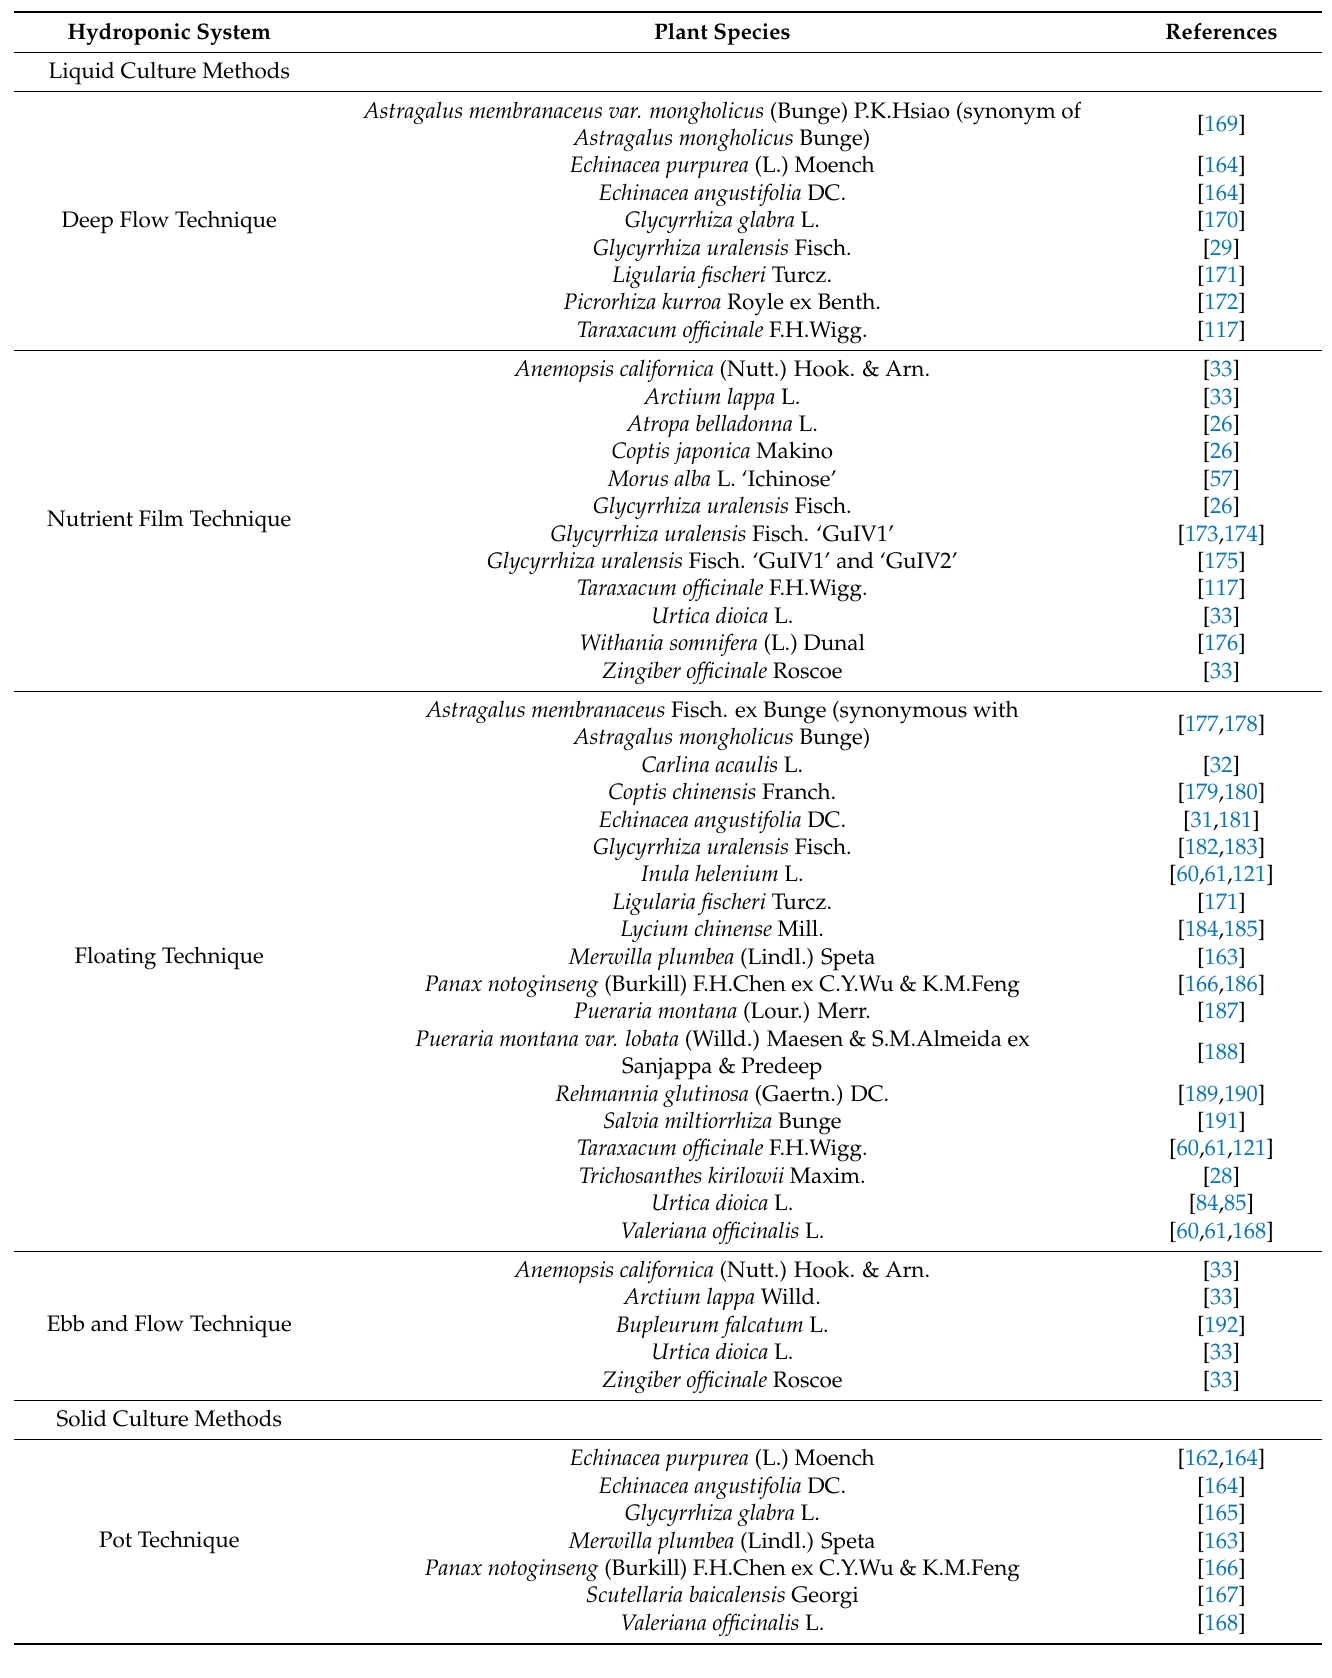
Table 3. Examples of publications discussing hydroponic cultivation of medicinal plants whose roots or rhizomes are